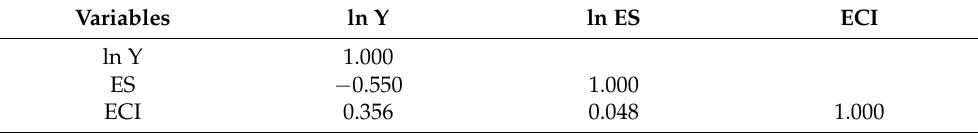
Table 2. Correlation matrix.